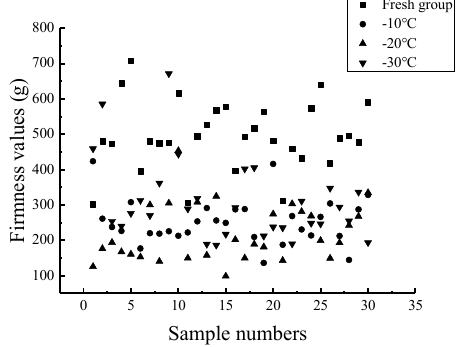
Figure 12. Scatter plot of the distribution of the firmness values of the Nanguo pears.